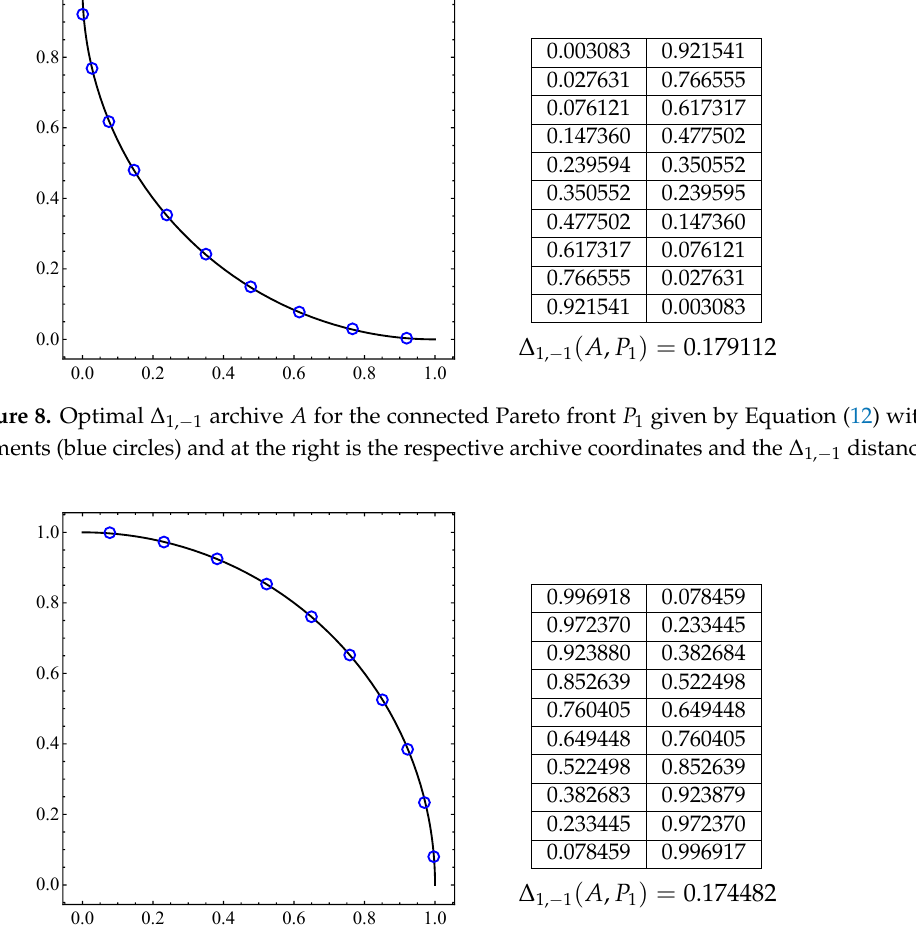
Figure 9. Optimal ∆ 1, − 1 archive A for the connected Pareto front P 2 given by Equation (12) with 10 elements (blue circles) and at the right is the respective archive coordinates and the ∆ 1, − 1